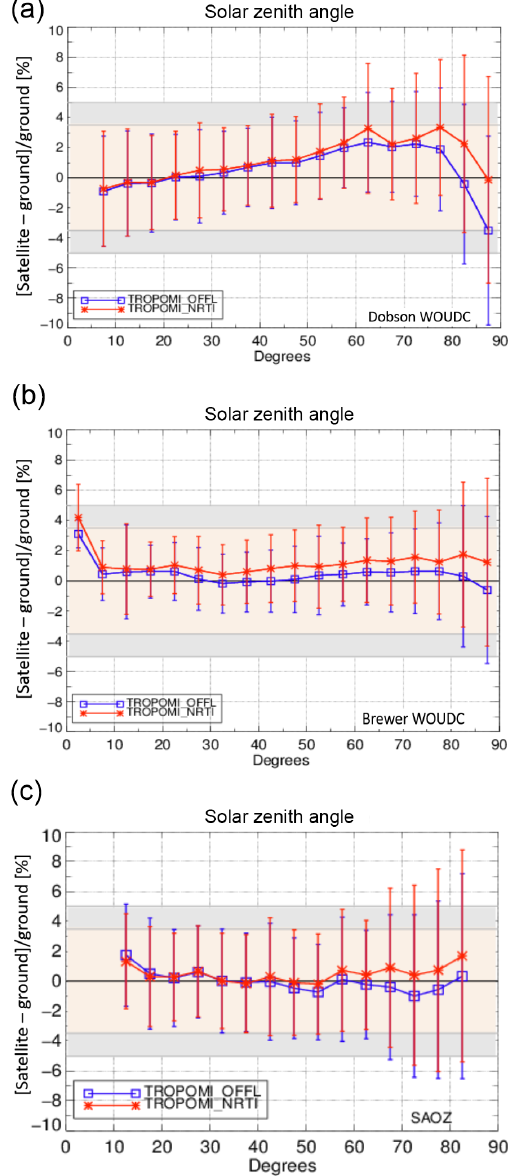
Figure 10. The two TOC products of the TROPOMI sensor com- pared to GB Dobson (a) , Brewer (b) and SAOZ (c) measurements versus the solar zenith angle of the satellite measurement (in de-